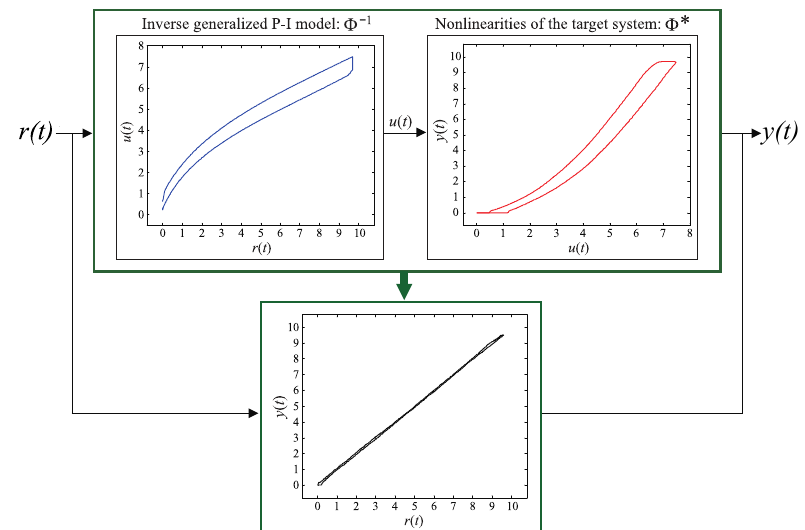
Figure 1. Illustration of nonlinearity compensation by an inverse hysteresis model.